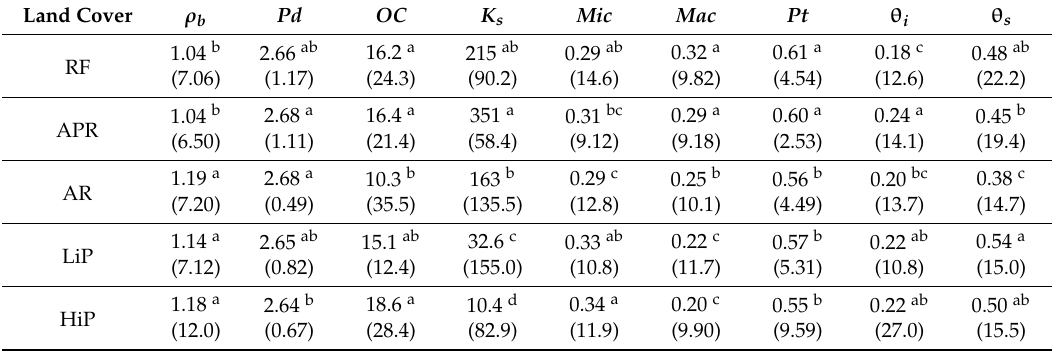
Table 3. Mean and associated coefficient of variation (CV, in parenthesis) of soil bulk density ( ρ b in g cm − 3 ), soil particle density ( Pd in g cm − 3 ), soil organic carbon content ( OC g kg − 1 ), saturated